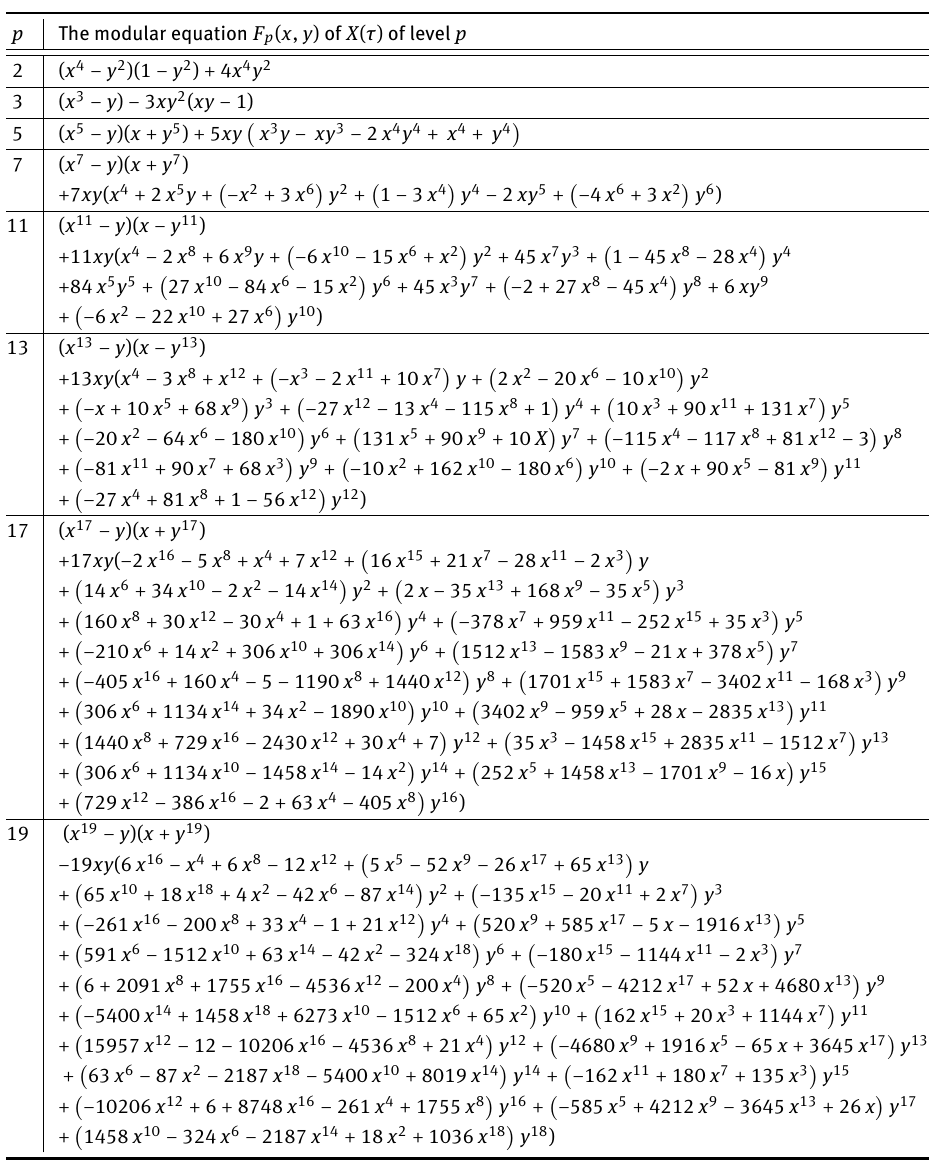
Table 1: The modular equation F p ( x , y ) of X ( τ ) of levels 2, 3, 5, 7, 11, 13, 17 and 19